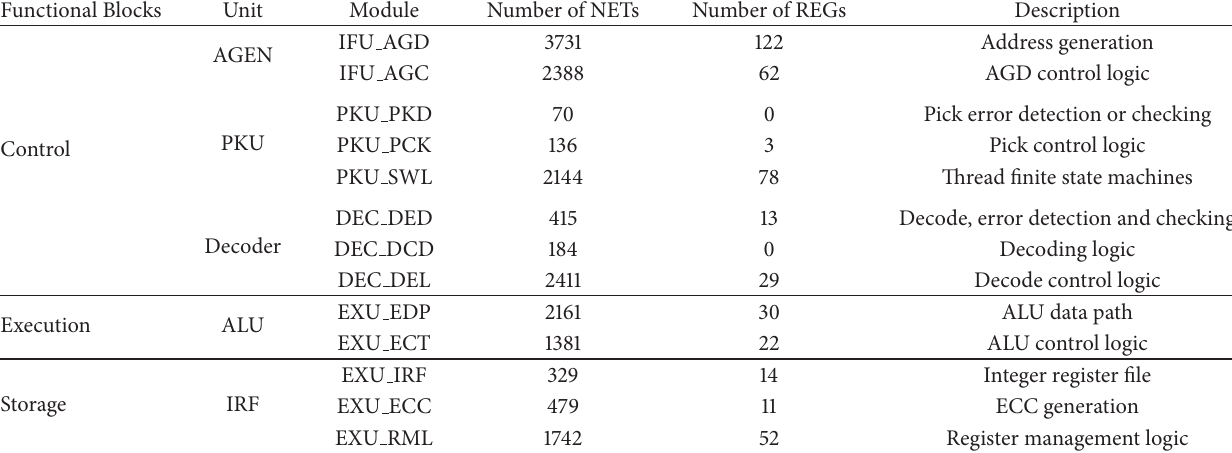
Table 1: Representative units and corresponding modules under investigation in the target CMT.